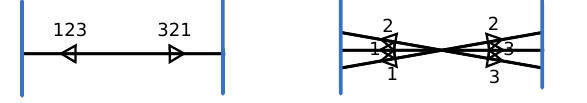
Figure 26 . Left: a leaf of F approx which meets L at two points. Right: the corresponding cluster of